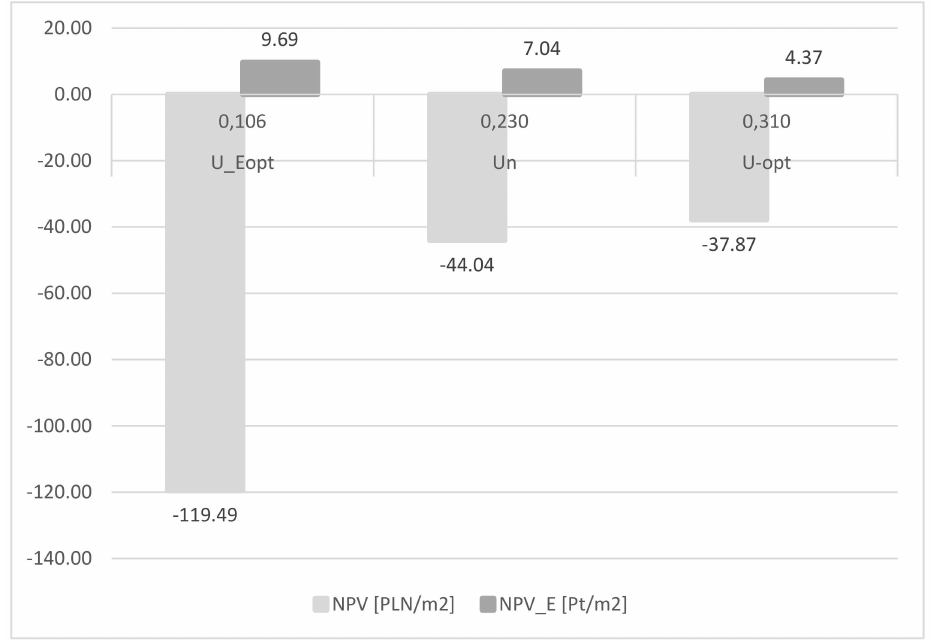
Figure 4. NPV and NPV E values depending on U for variant CC-CB-PUR and climate zone